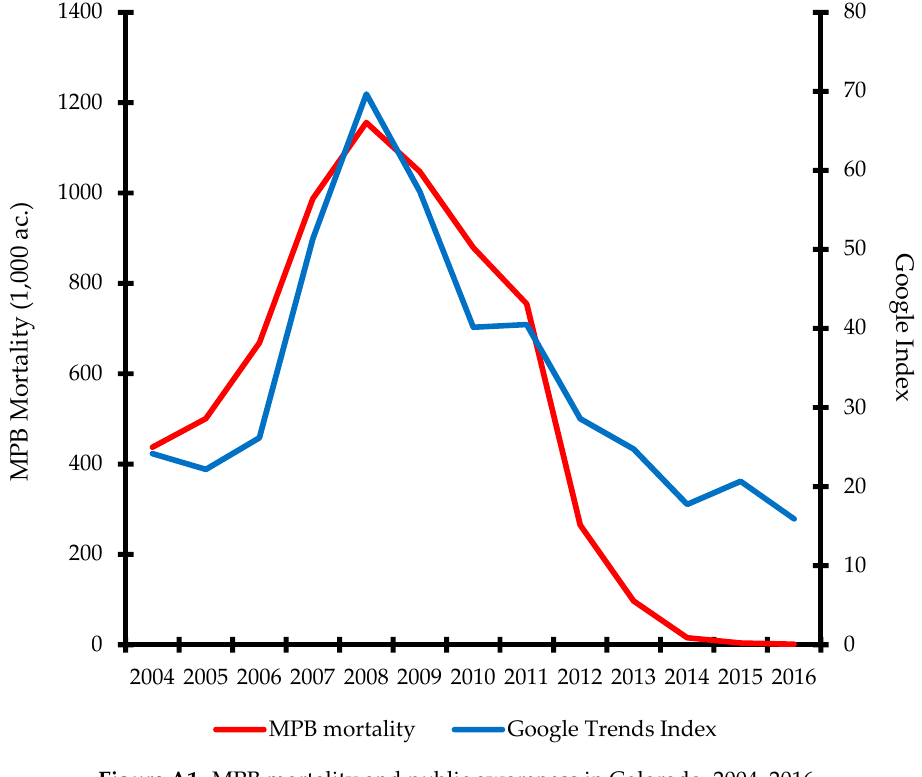
Figure A1. MPB mortality and public awareness in Colorado, 2004–2016.